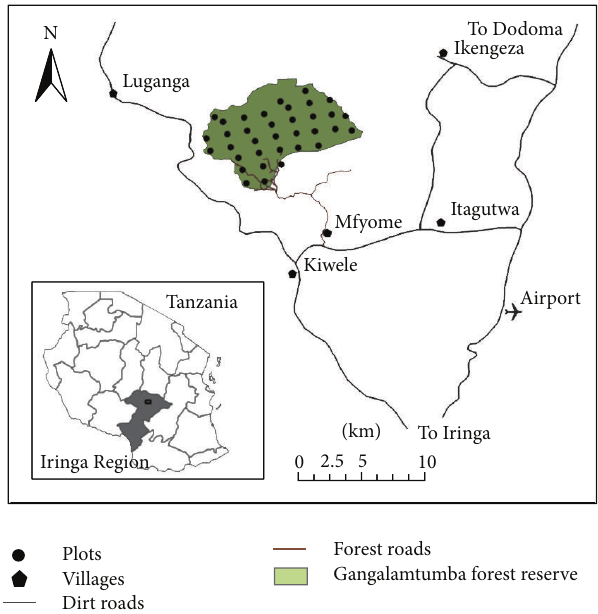
Figure 1: Map of the study area and its location in Iringa Region,